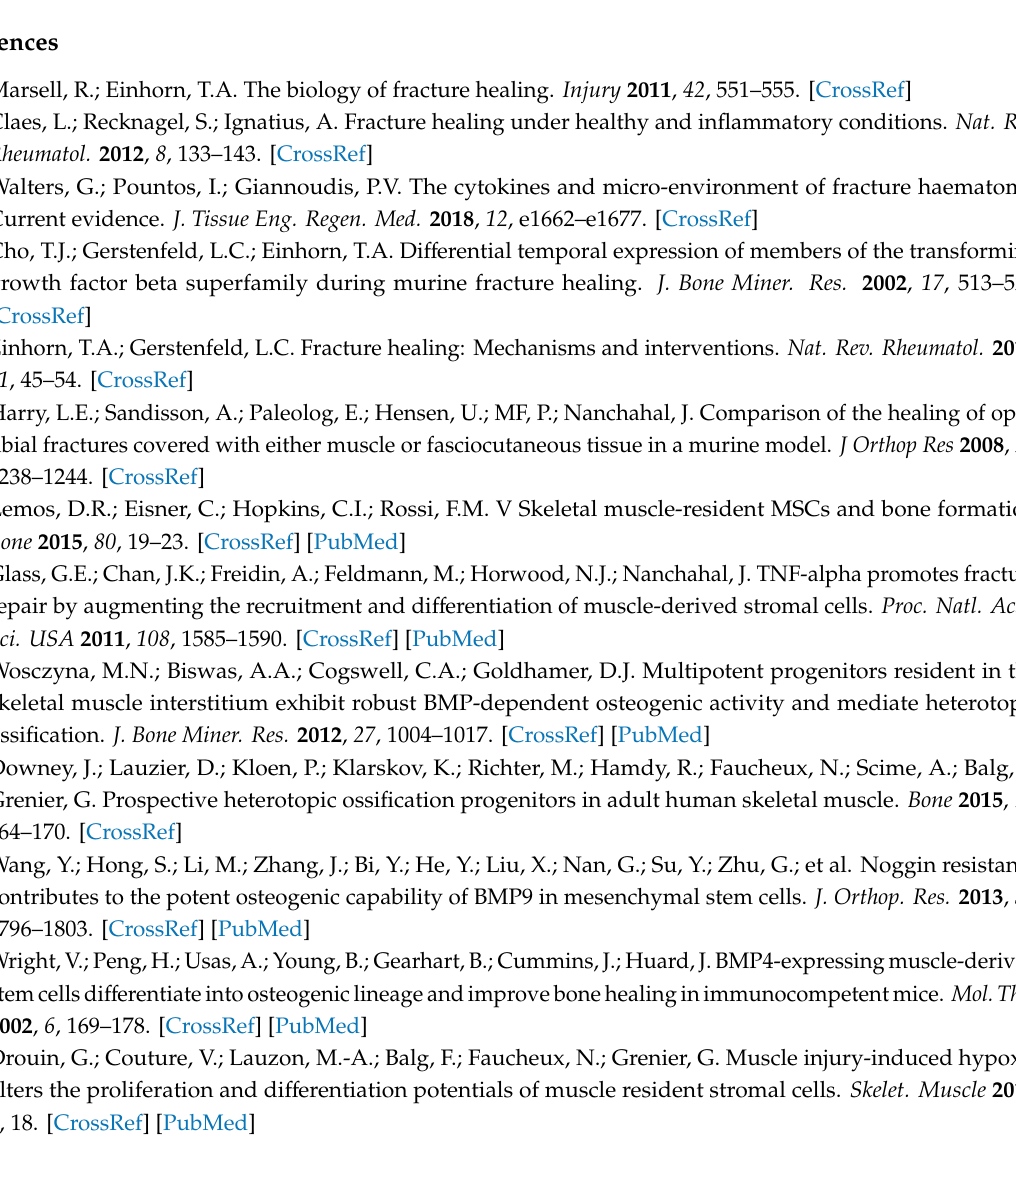
Table S1. Statistical significance and e ff ect of cytokines from cluster #1. Figure S1. (A) Correlation matrix of ELISA multiplex data from serum from 8 healthy donors (HH-#) versus 8 hematoma extracts from pelvic fractures (Hema-#) organized in respect to their sex. (B) PCA analysis of ELISA multiplex cytokine dosage showing the scores depicted as individuals according to their sex. (C) Correlation matrix of ELISA multiplex data from 8 healthy donor serum (HH-#) versus 8 hematoma extracts from pelvic fracture (Hema-#) organized in respect to their age. (D) PCA analysis of ELISA multiplex cytokine dosage showing the scores depicted as individuals according to their